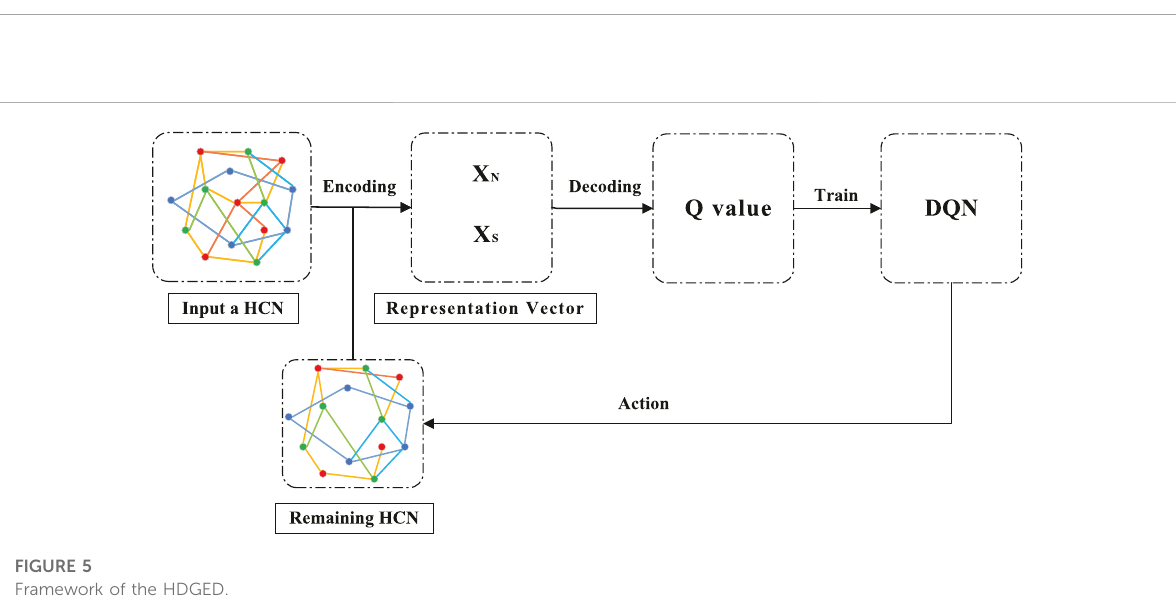
FIGURE 5 Framework of the